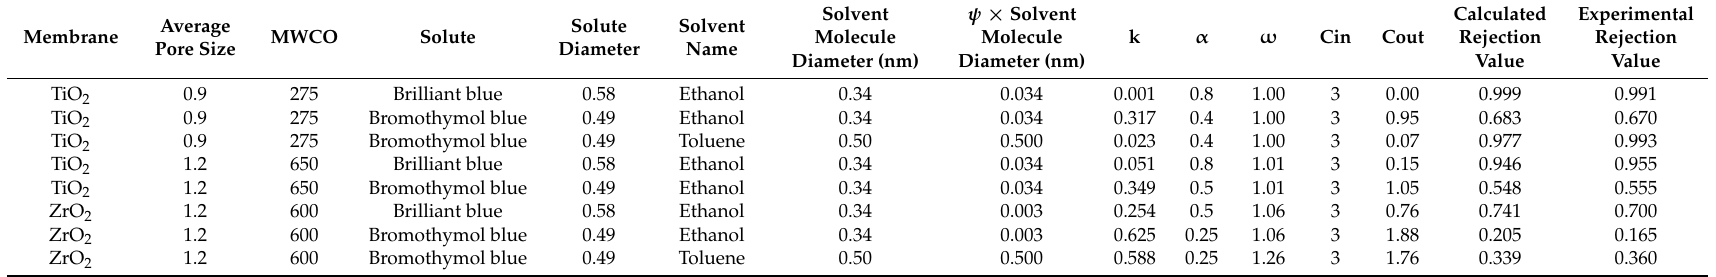
Table 5. Evaluating the proposed model by solvent flux and solute rejection value through the ceramic membrane reported by [48].